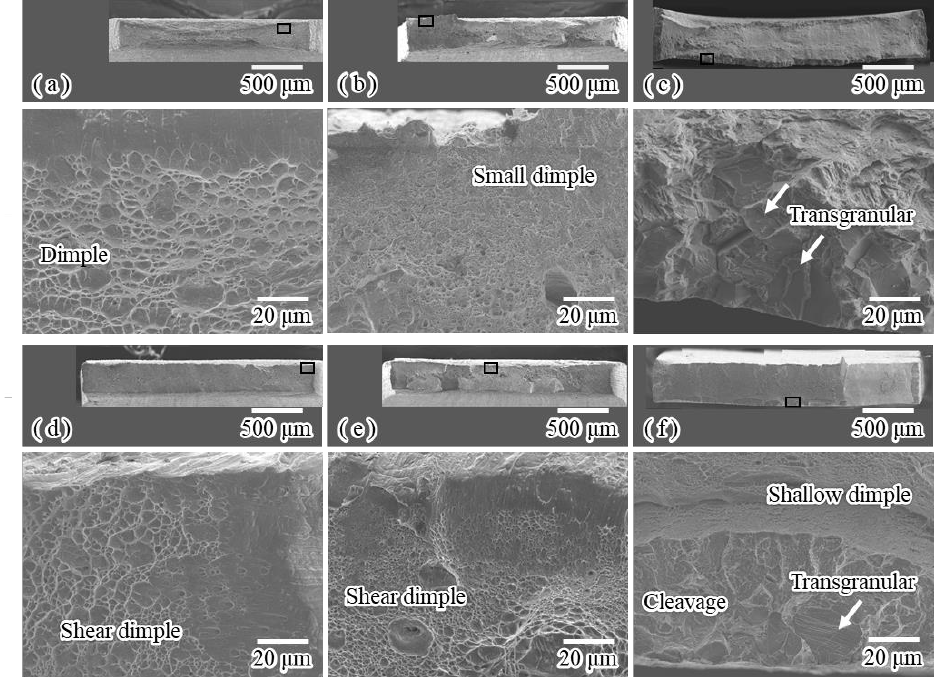
Figure 7. SEM images of general and magnified views of representative fracture surfaces for ( a ) uncharged specimen, specimens subjected to ( b ) conventional and ( c ) modified hydrogen charging fractured at 25 °C, ( d ) uncharged specimen, and specimens subjected to ( e ) conventional and ( f ) modified hydrogen charging fractured at −196 °C.